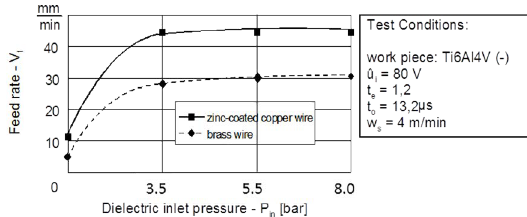
Figure 6. The influence of dielectric inlet pressure P feed rate V for uncoated brass and zinc-coated copper wires f